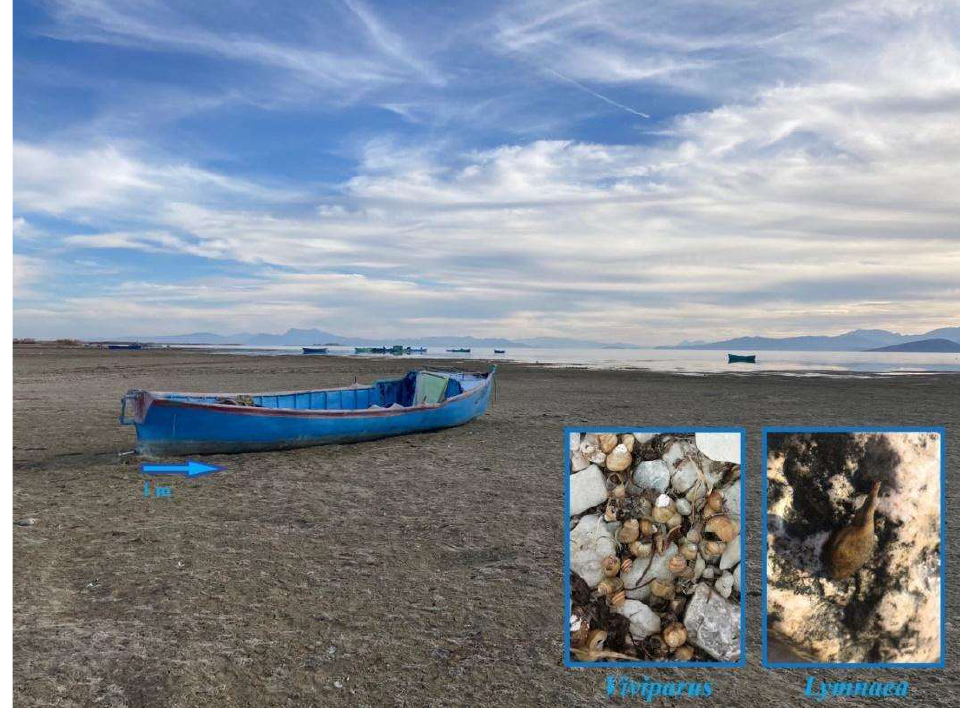
Figure 9. Flock mortality in freshwater snails following excessive water withdrawal in Beyşehir Lake ( Viviparus viviparus , 4.5 cm width; 1 survivor of Lymnaea stagnalis , 5 cm height; small fishing boat, 6 m length; photographed by Burçin Aşkım Gümüş on November 2021).